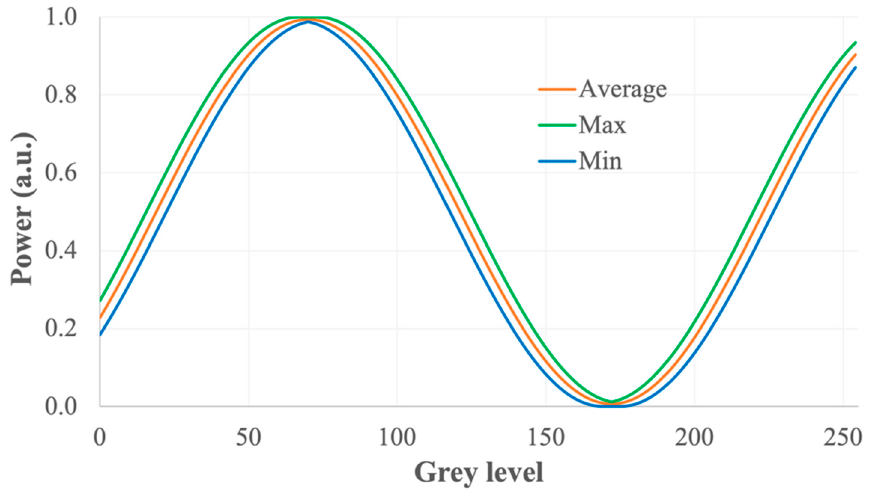
Figure 4. The simulated power response when there is noise in the characterisation system.